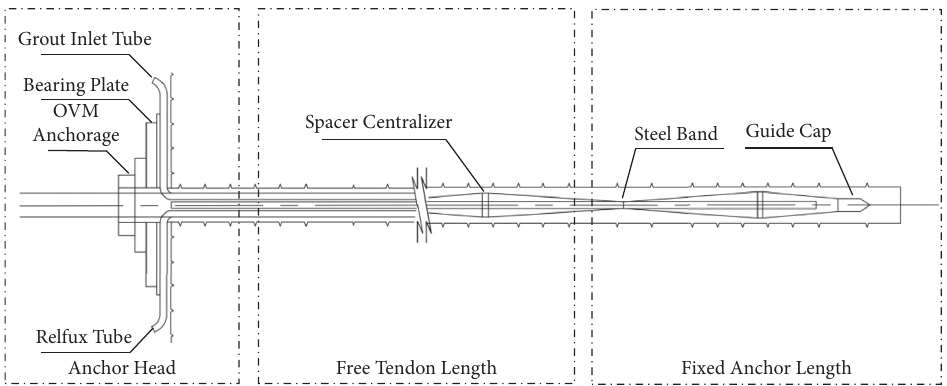
Figure 2: Design drawing of the anchor cable.